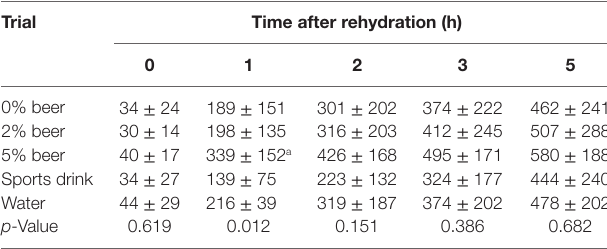
TaBle 3 | cumulative urine output.